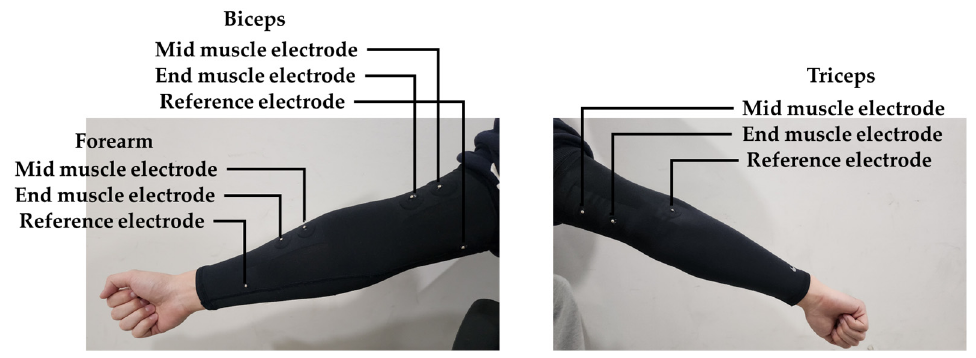
Figure 6. Electrode position of arm sleeve device.